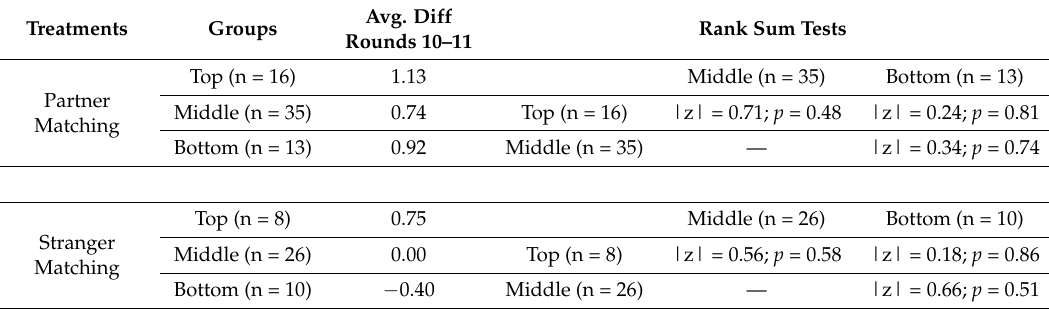
Table A3. Rank sum tests comparing differences in beliefs between Rounds